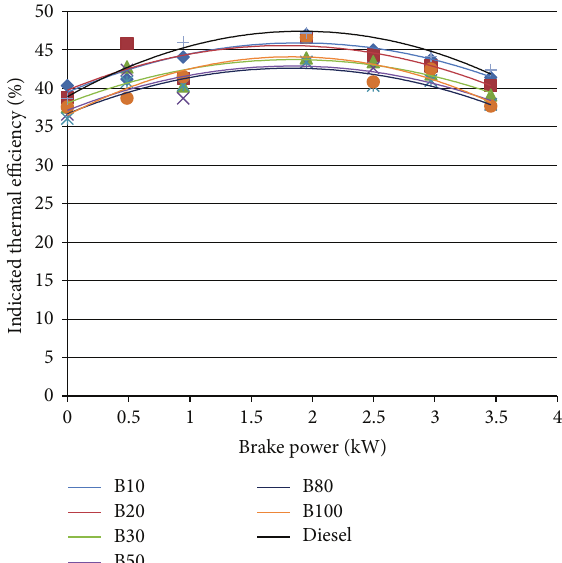
Figure 6: Indicated thermal efficiency versus brake power.